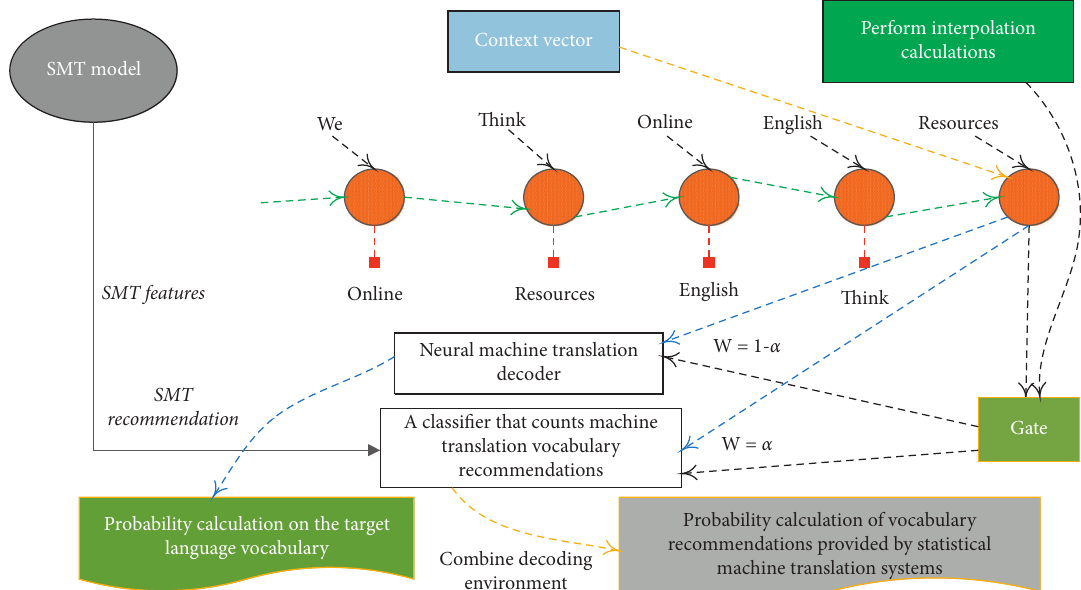
Figure 4: Door control model for statistical machine translation vocabulary recommendation.